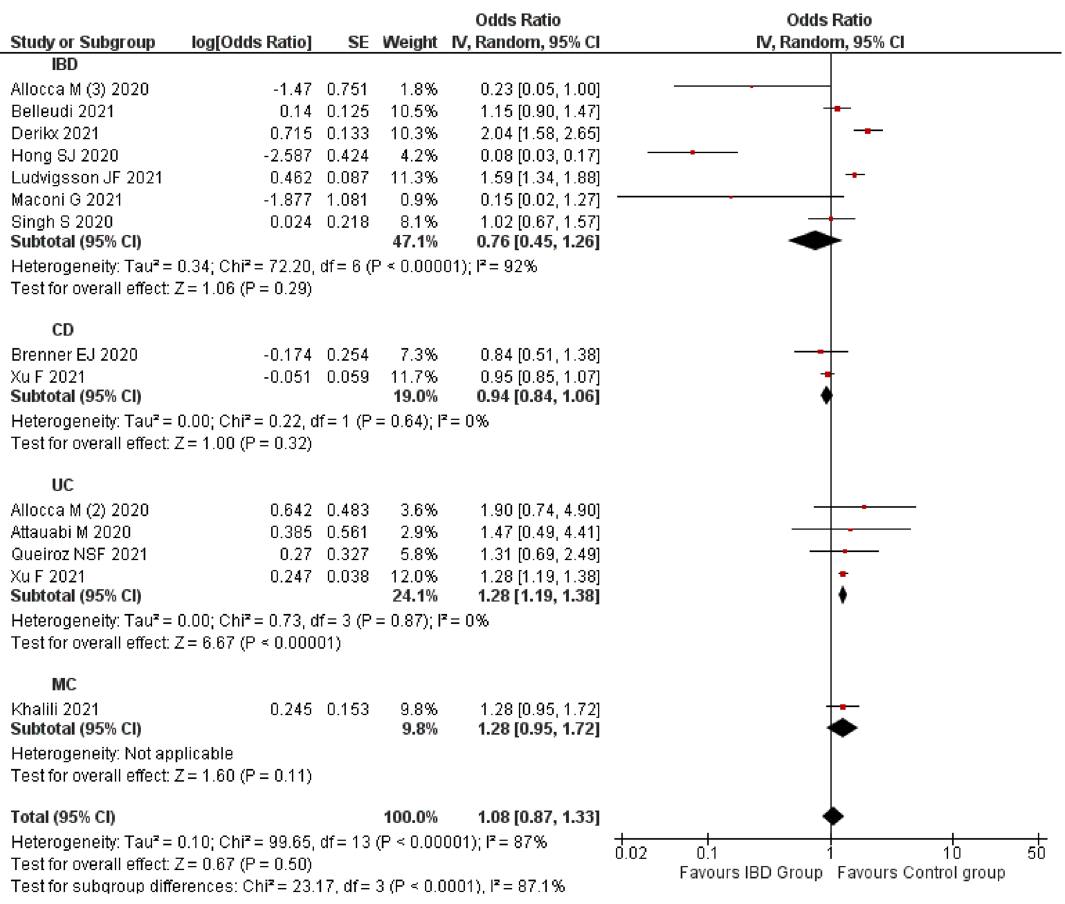
Figure 5. Risk of COVID-19 hospitalization among the patients with